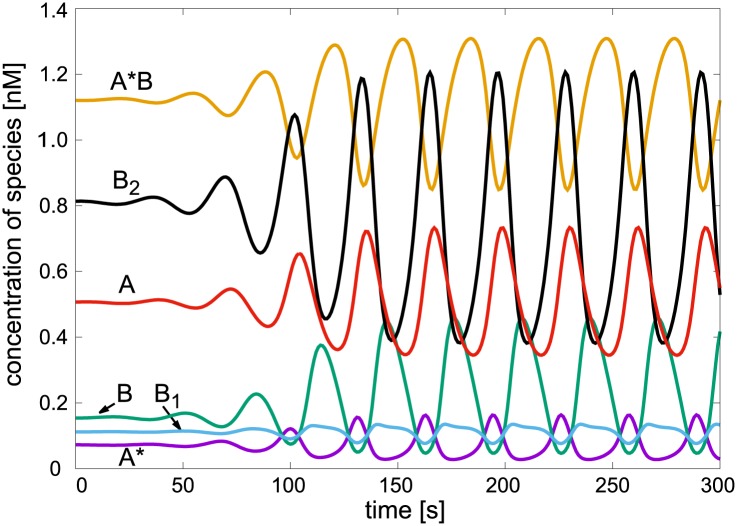
Oscillatory dynamics in the minimal model.Parameters: k6 = 0.1 s−1, Atot = 1.7 nM, other parameters are given in the text.